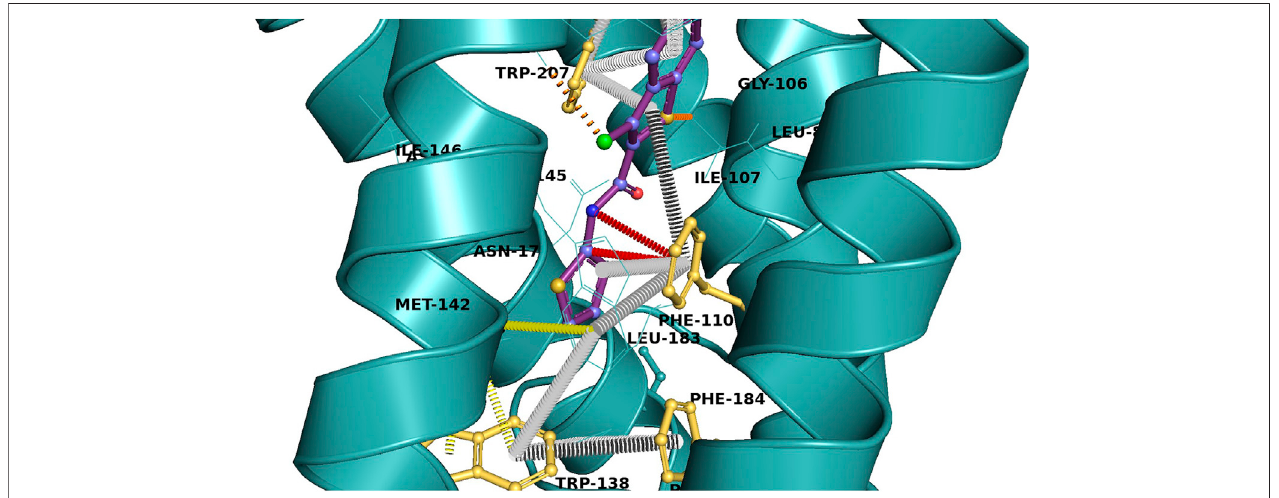
FIGURE 3 | The residue F110 facilitates the pi – pi cascade (grey rings) between aromatic residues in the binding pocket of EthR (yellow) and the ligand (purple), which later translates into a structural modi fi cation of the HTH motif and inhibition of DNA binding. Analysis of the interactions was performed using Aperggio (http:// bleoberis.bioc.cam.ac.uk/arpeggioweb/) and viewed using